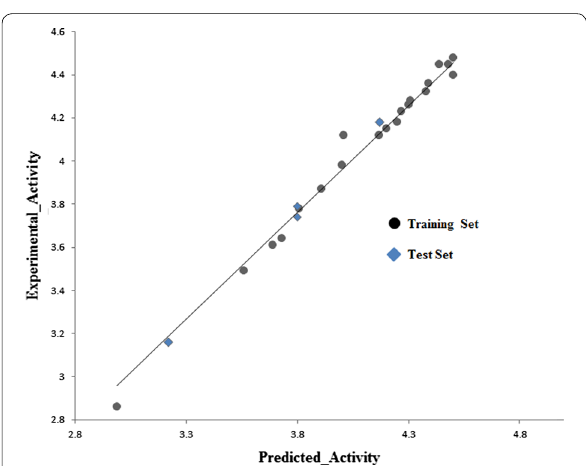
Fig. 7 Plot of experimental vs. predicted activity for CoMSIA model of glucose uptake